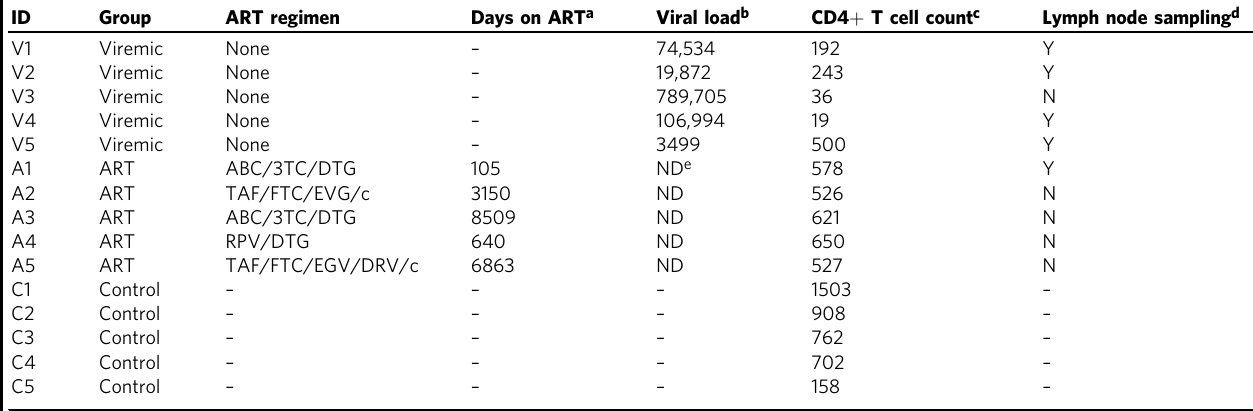
ART antiretroviral therapy, ABC abacavir, DTG dolutegravir, 3TC lamivudine, TAF tenofovir alafenamide, RPV rilpivirine, EVG elvitegravir, c cobicistat, DRV darunavir. a Continuous ART since last viremic episode. b Plasma HIV-1 RNA copies/mL. c Cells/mL.